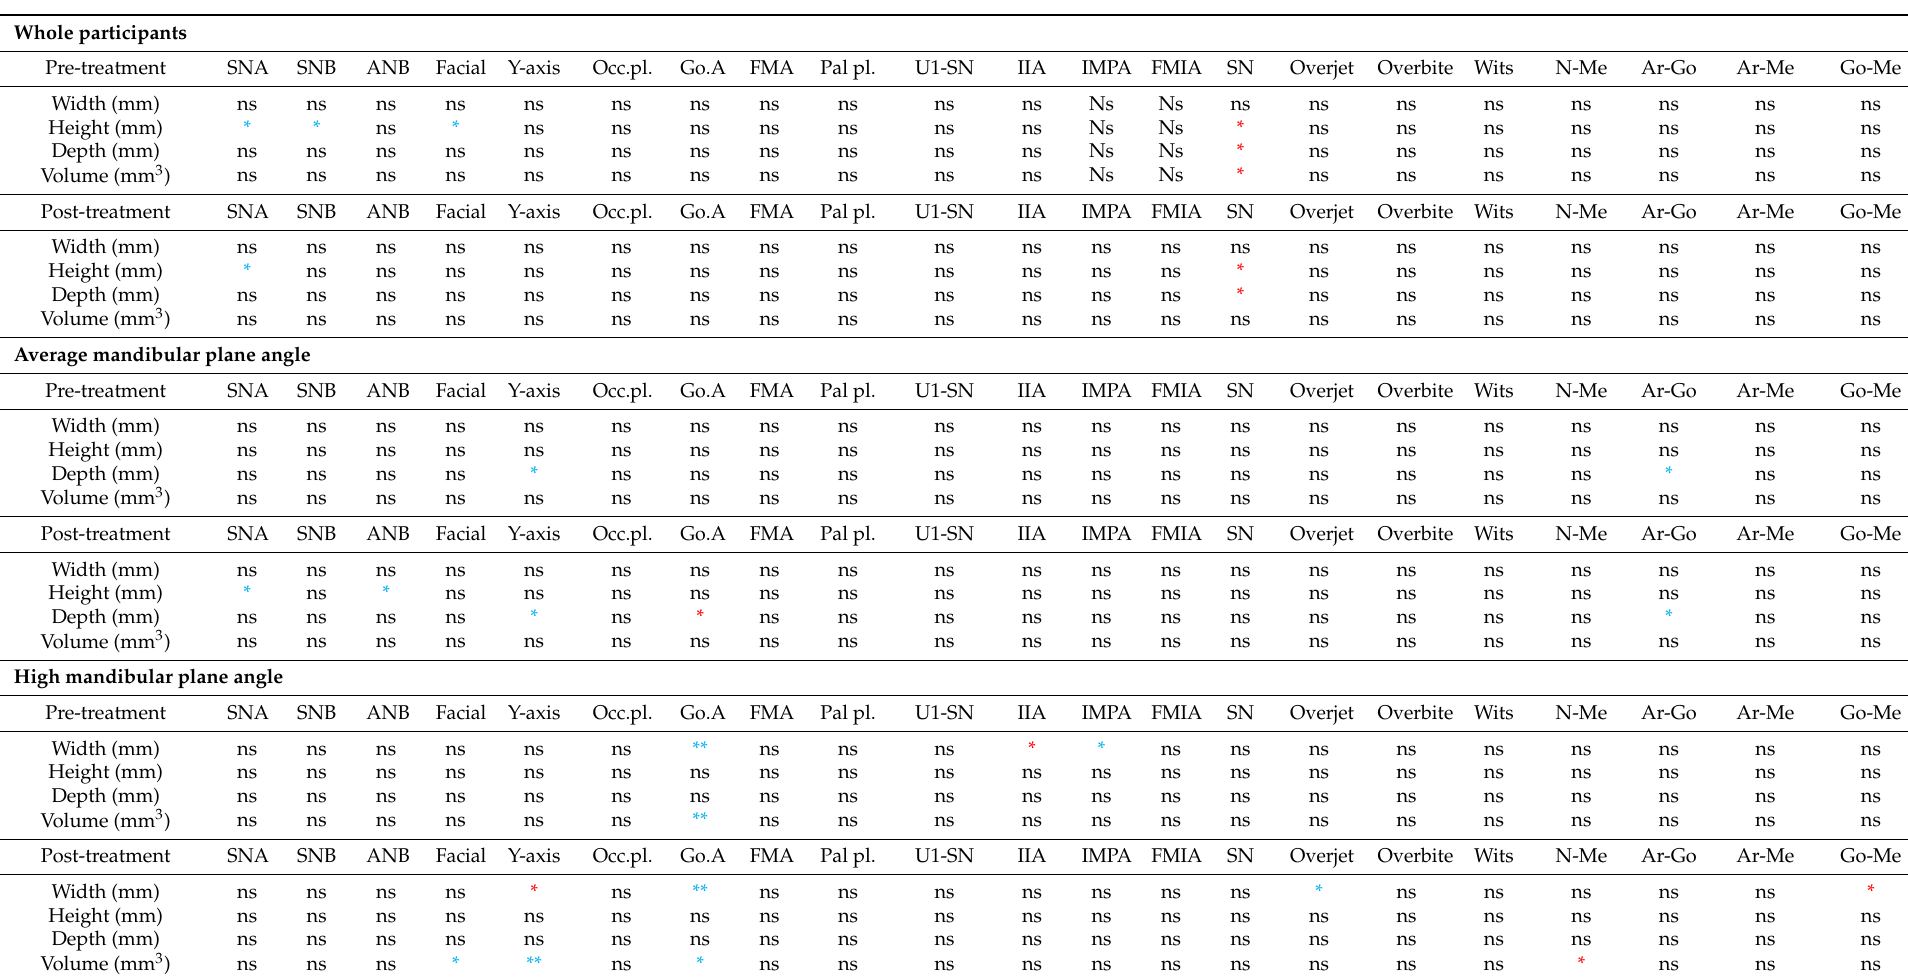
Table 3. Correlations between the cephalometric measurements and frontal sinus